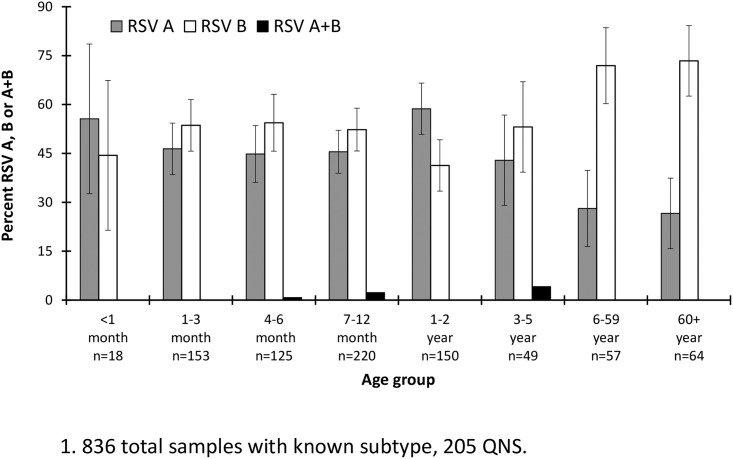
OUTSMART 2016–17 percent RSV-positive tests by age and subtype.Error bars represent 95% confidence intervals.